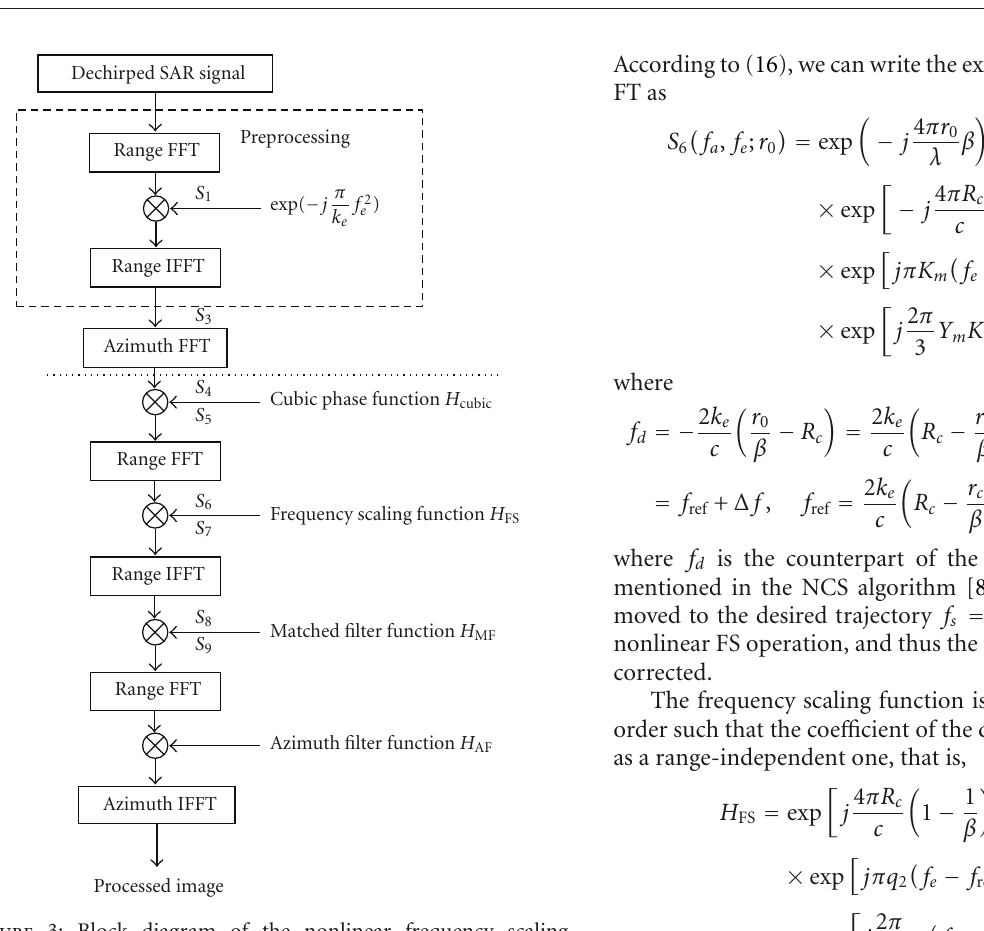
Figure 3: Block diagram of the nonlinear frequency scaling